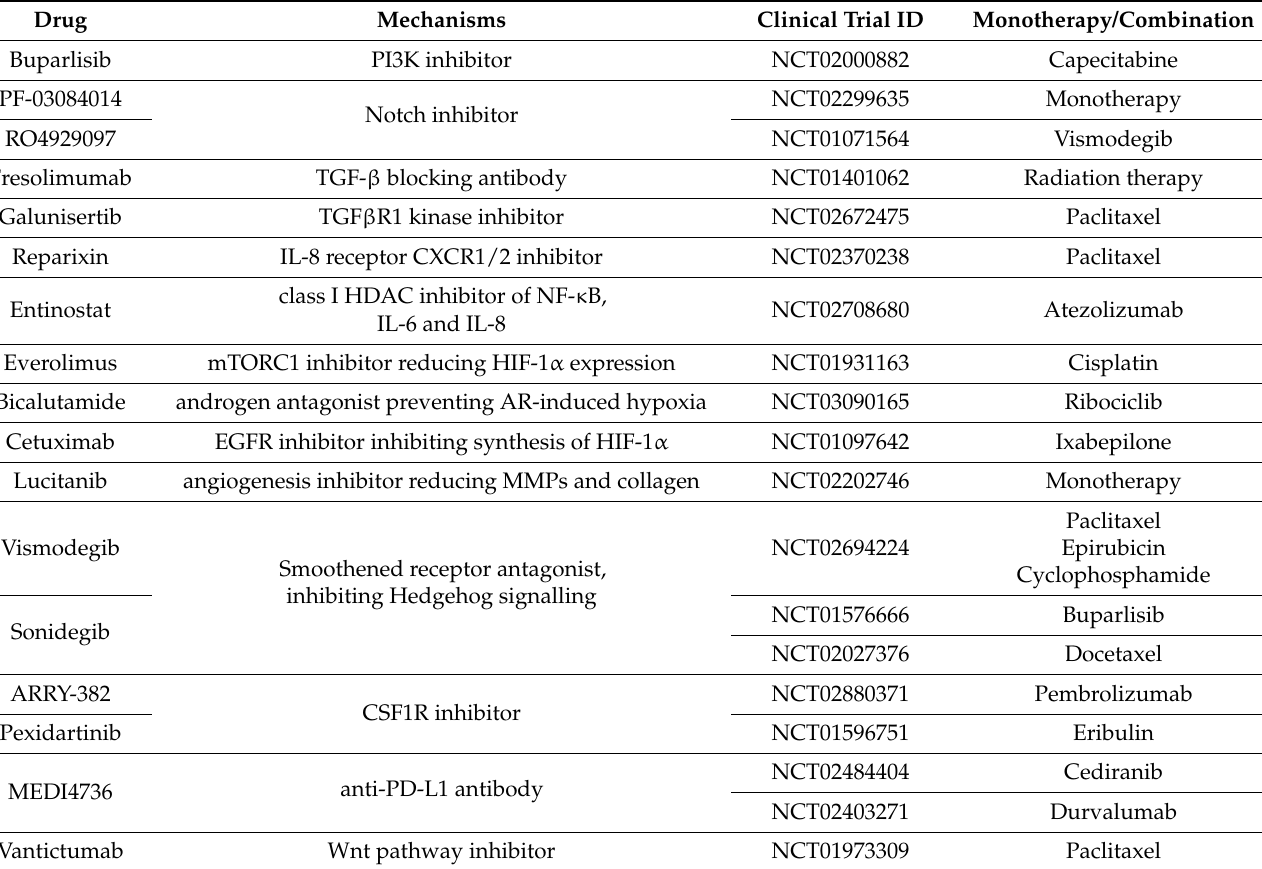
Table 1. A list of drugs targeting EMT regulatory components in TNBC clinical